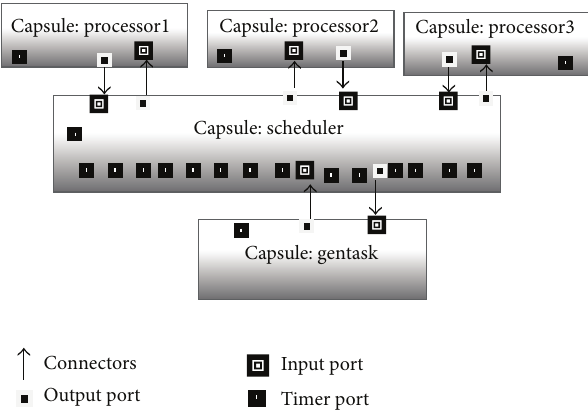
Figure 1: Multiprocessor system modelled in